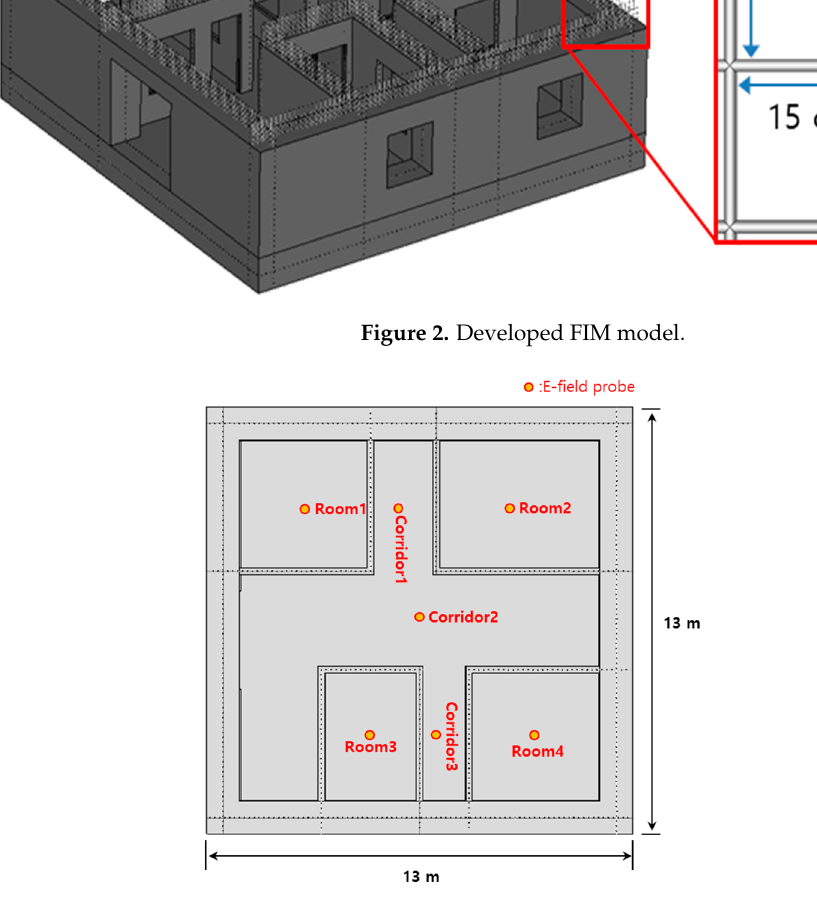
Figure 3. Sensor locations.